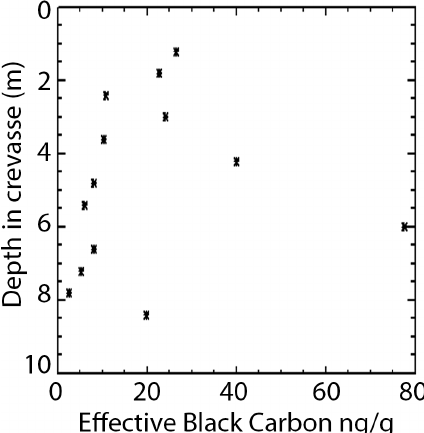
Figure 10. eBC from snow samples collected from the walls of a crevasse on Vallunaraju (region 4) the nearest high mountain to Huaraz. A decreasing trend with depth is noted. These lowest sam- ples were visually the cleanest snow samples from the crevasse walls, and were likely to have accumulated during the wet season. The points at 4, 6, and 8.5m were thin noticeably dark